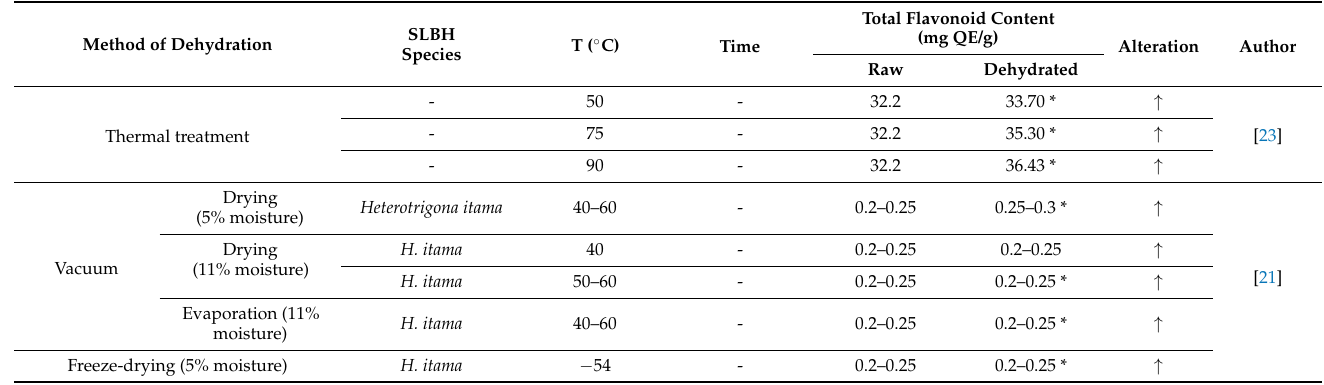
Table 12. Total flavonoid content of raw and dehydrated stingless bee honey (SLBH).